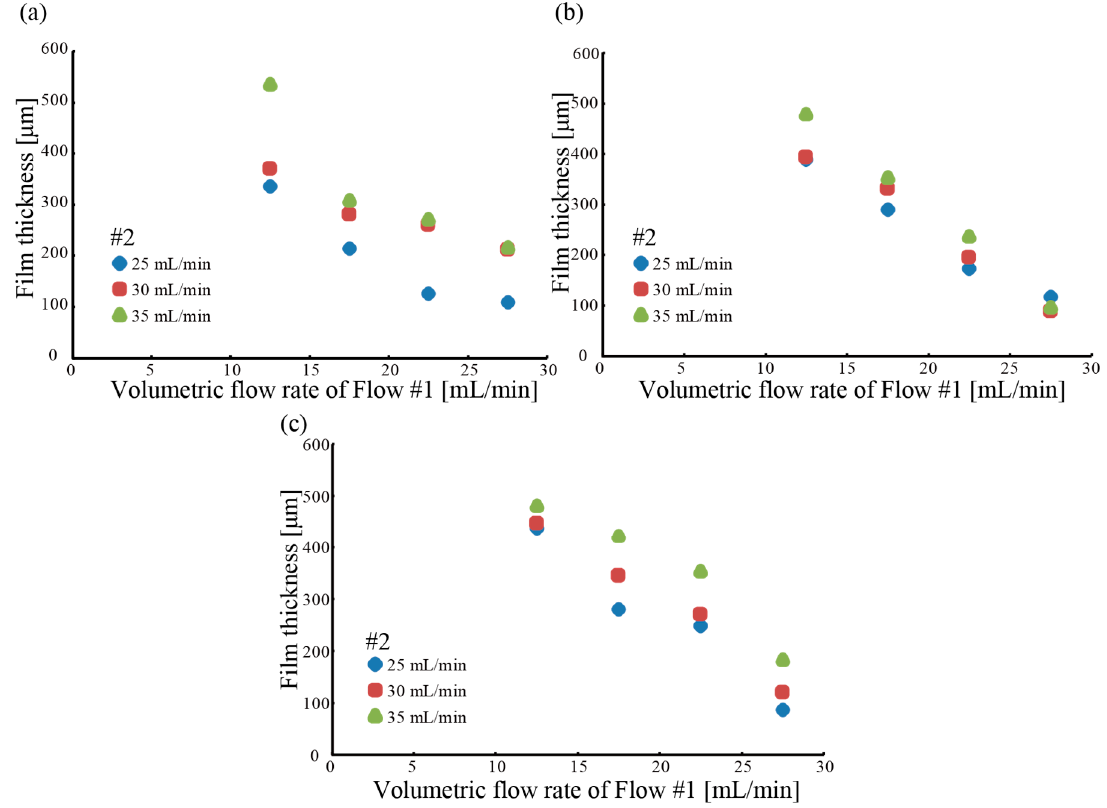
Figure 5. Relationship between film thickness of microtube and volumetric flow rates of fluids #1 and #2. ( a ) Outlet diameter of Part 2 is 2.5 mm. ( b ) Outlet diameter of Part 2 is 2.7 mm. ( c ) Outlet diameter of Part 2 is 2.9 mm.